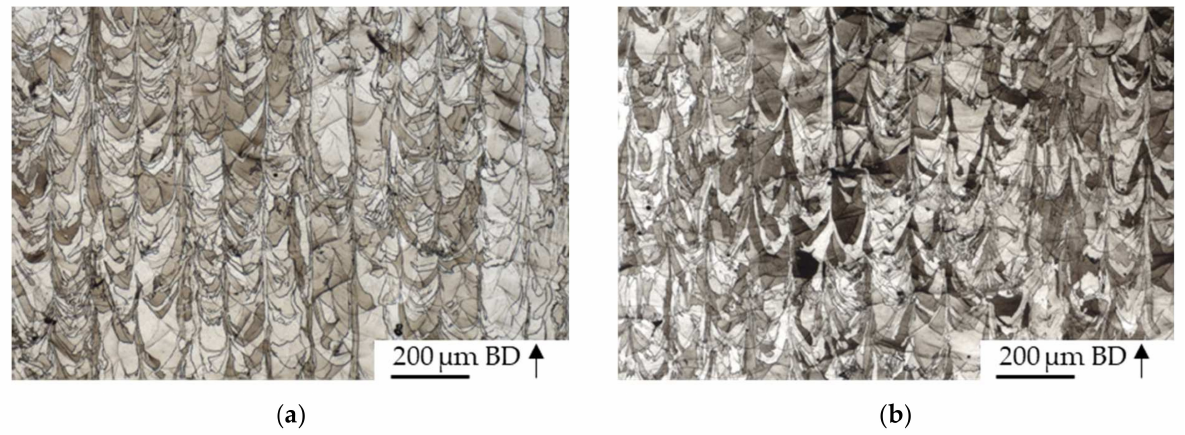
Figure 7. Microstructure of AB L-PBF-processed AISI 318LN under an ( a ) argon atmosphere or ( b ) nitrogen atmosphere. BD: building